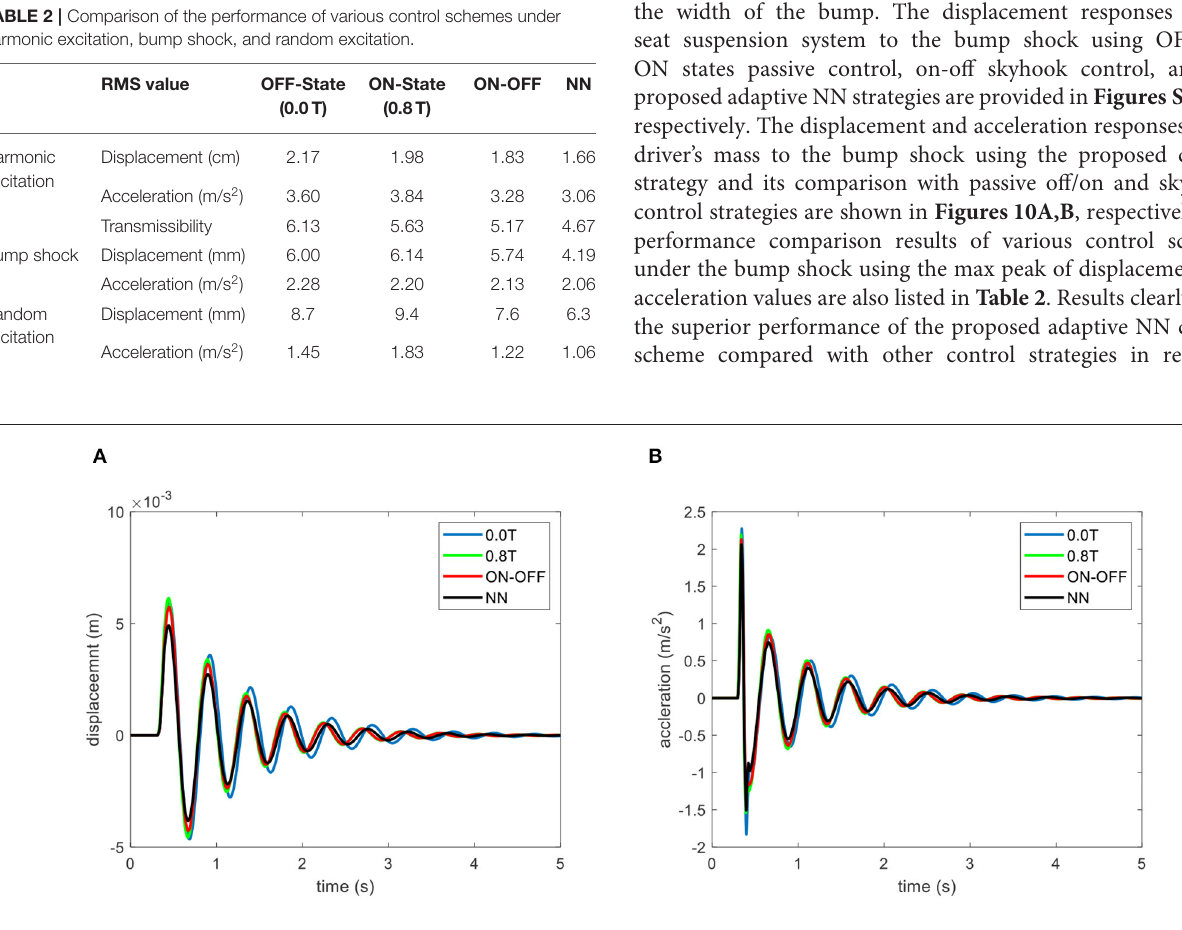
Frontiers in Materials |